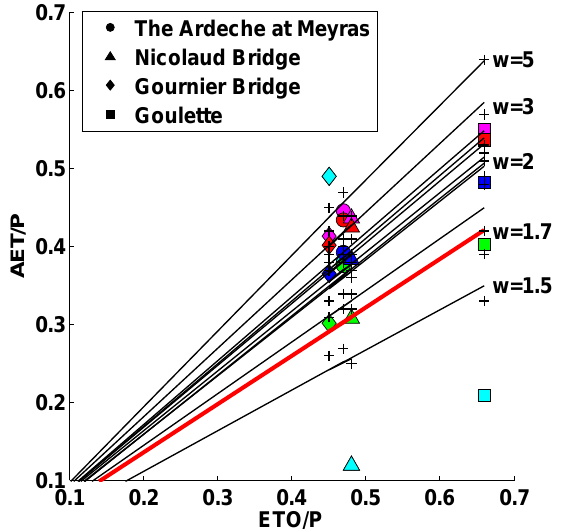
Figure 4. Mean annual evapotranspiration ratio AET /P as a func- tion of the dryness index ET 0 /P for different values of param- eter w , using the Fu (1981) curve and different formulas (Turc, Schreiber, Pike, Budyko; see Table 5). Colours correspond to differ- ent formulas (cyan = original data; green = Turc, blue = Schreiber, pink = Pike, red = Budyko) and shapes represent different exam- ined